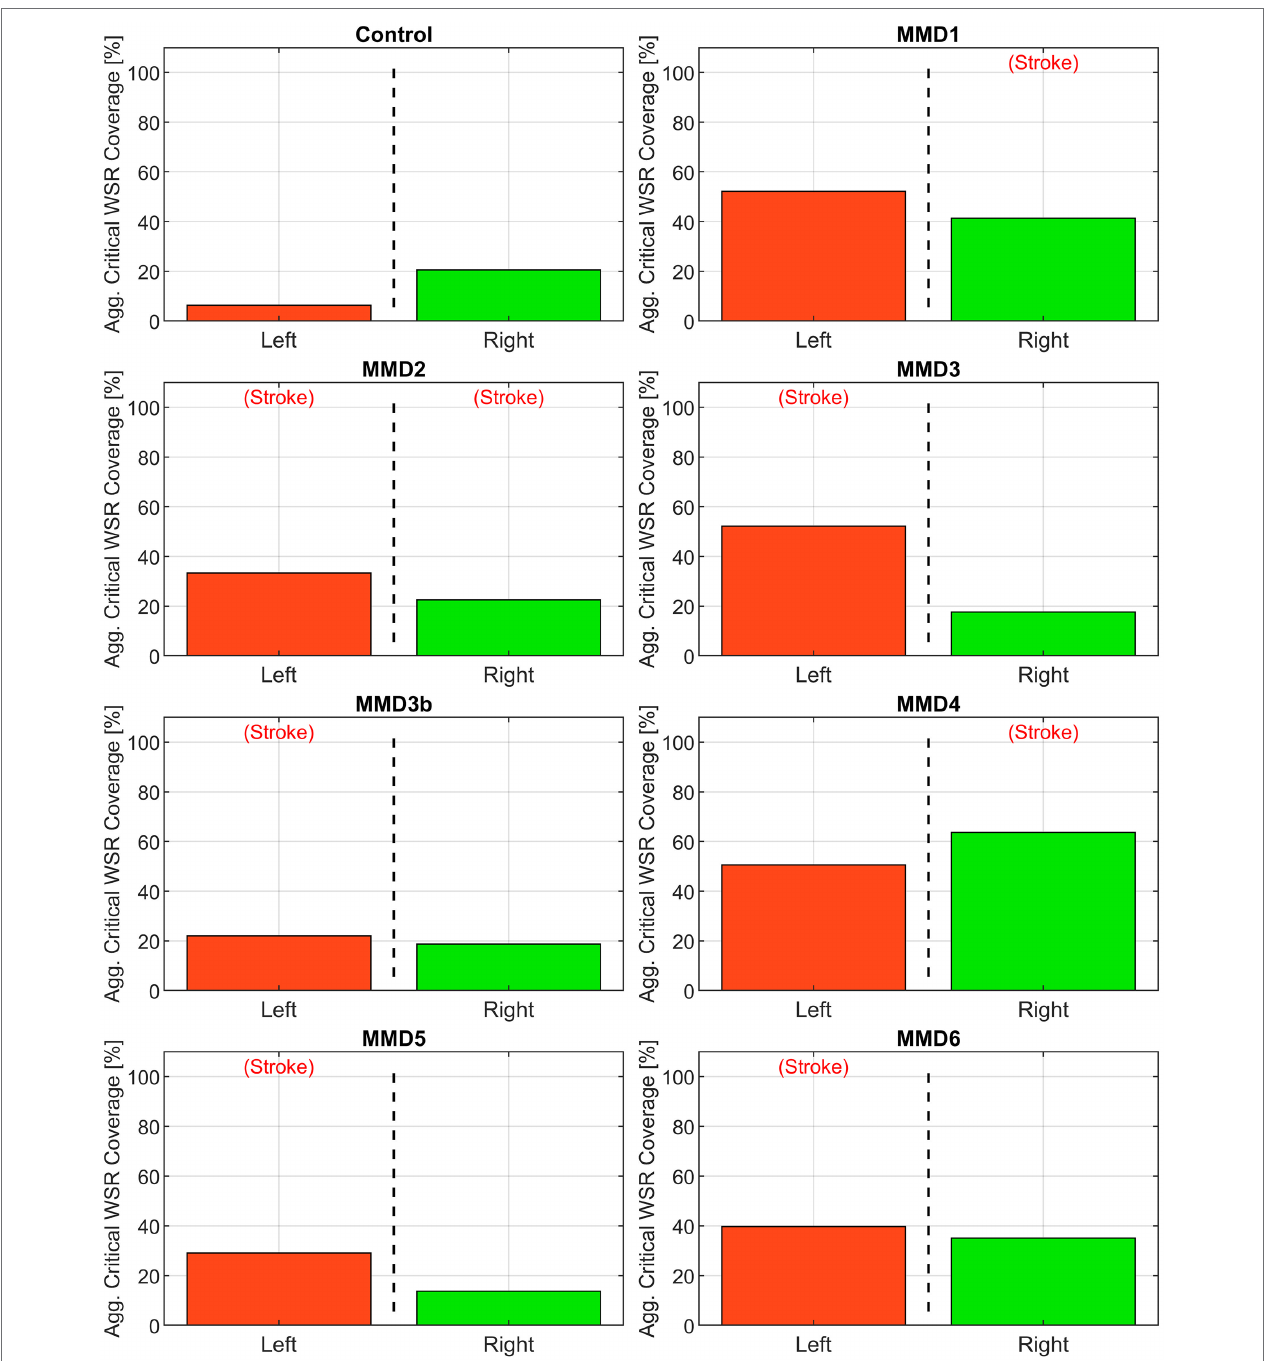
FIGURE 5 | Aggregate critical WSR coverages for the left and right sides of the anterior circulation (MCA, ACA, and ICA) for the control subject and the six patients we studied as: MMD1, MMD2, MMD3 and MMD3b, MMD4, MMD5, and MMD6. The percentage is calculated as the sum of the surface area exceeding WSR >5,000 s − 1 in the three vessels divided by the sum of the surface areas of the three vessels. The label (Stroke) indicates the side of primary stroke